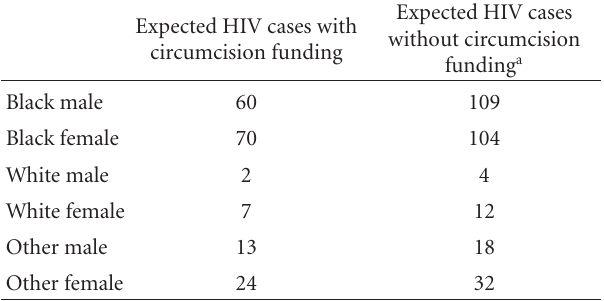
Table 7: Expected heterosexually acquired HIV cases in South Carolina for the 2009 medicaid birth cohort aged through age 49 with and without circumcision